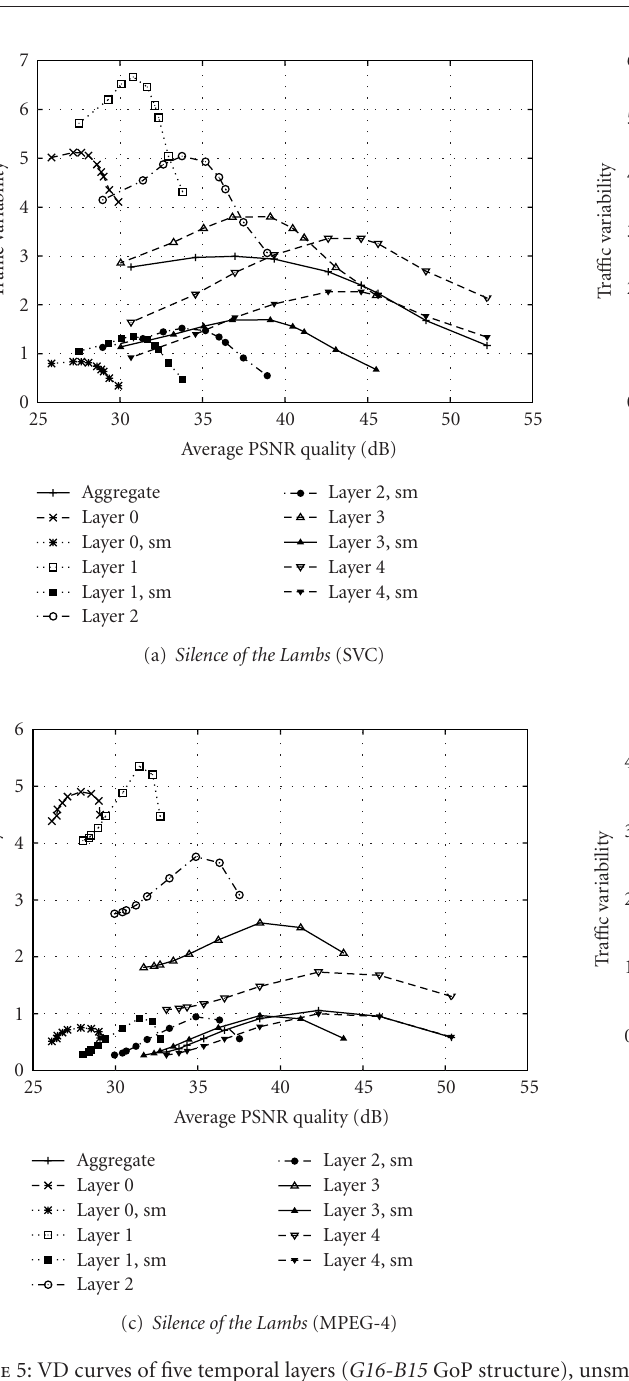
Figure 5: VD curves of five temporal layers ( G16-B15 GoP structure), unsmoothed, smoothed ( sm ), and aggregated ( aggr ), for the Silence of the Lambs and Star Wars IV